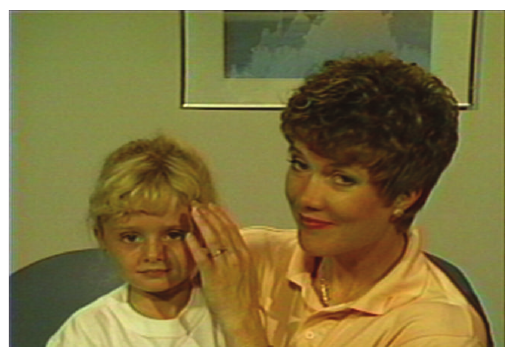
Figure 10: Frame 1 in